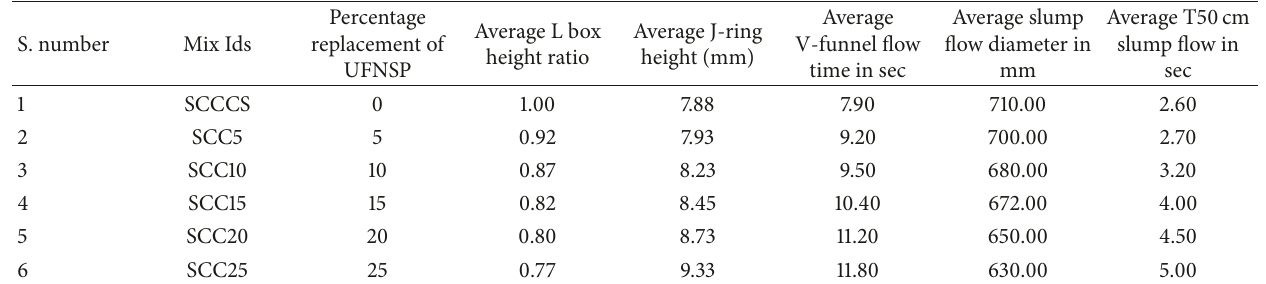
Table 2: Results on flow properties of fresh concrete.